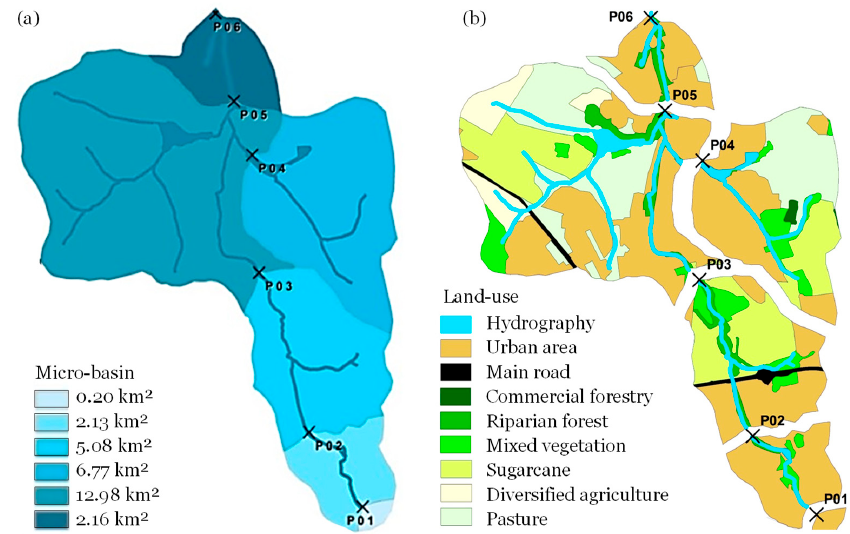
Figure 2. Micro-basin areas ( a ) and land uses ( b ) at sampling points.